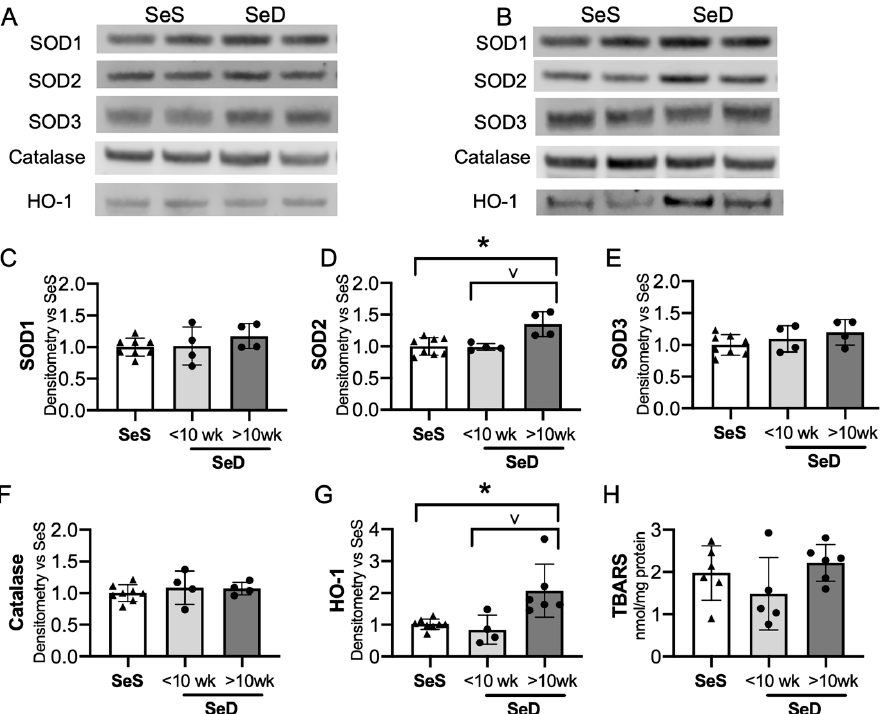
Figure 6. Neonates born to dams with prolonged Se deficient exhibit increased hepatic SOD2 and HO-1. C57Bl/6 mice were placed on diets that differed only in Se content, either 0.4 ppm or <0.01 ppm of sodium selenite. Breeding was initiated after 2–4 weeks on diet and natural delivery was allowed. Hepatic organ homogenate was evaluated on day of birth. Each data point represents either a female or male from each litter; each individual point is an average of two mice. ( A ) Representative Western blots of hepatic SOD1, SOD2, SOD3, catalase, and HO-1 for SeS samples and SeD samples born to dams who received <10 weeks SeD diet, ( B ) representative Western blots of hepatic SOD1, SOD2, SOD3, catalase, and HO-1 for SeS samples and SeD samples born to dams who received >10 weeks SeD diet, densitometric analysis of ( C ) SOD1, ( D ) SOD2, ( E ) SOD3, and ( F ) Catalase, ( G ) HO-1 protein content expression. Results are normalized to total protein stain and expressed as a ratio to SeS mice. ( H ) TBARS expression, expressed as a ratio to SeS mice N = 4–8 for all groups. Data are presented as mean ( ± SEM), * p < 0.05 vs. SeS control, by multiple comparison after one-way ANOVA, ∨ p < 0.05 vs. SeD <10 weeks by multiple comparisons after one-way ANOVA.